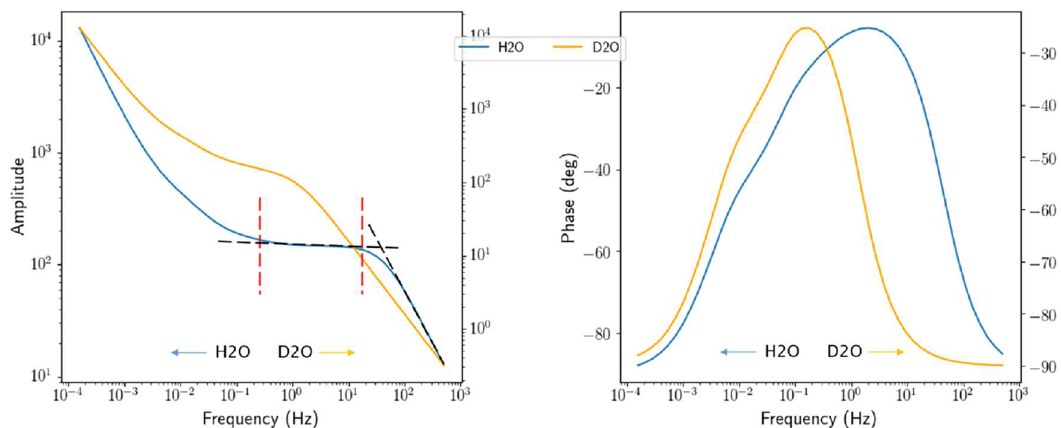
Fig. 2. Typical ZPTF for light and heavy water moderated